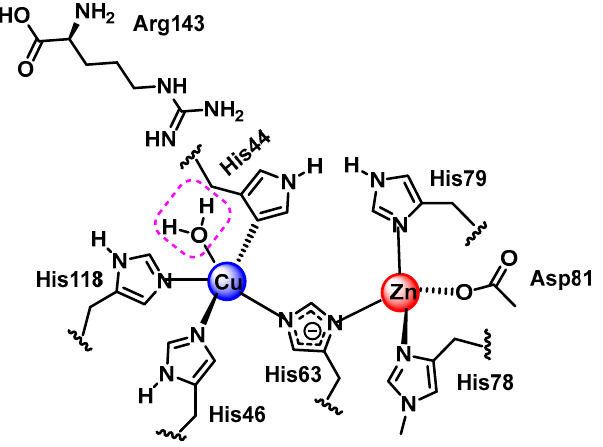
Figure 33. SOD1 catalytic centre.